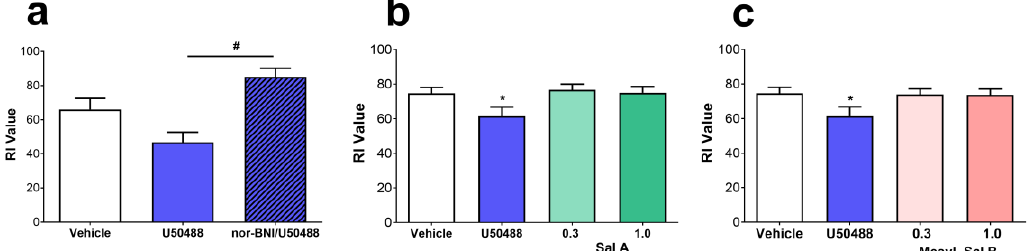
Figure 6. The effects of KOPr agonists on the novel object recognition task. ( a ) Rats treated with U50488 (10 mg/kg) decreased the recognition index (RI) value in the novel object recognition task which was prevented by the prior administration of nor-BNI (10 mg/kg, s.c.; n = 6). No change in the RI value was seen with either ( b ) Sal A or ( c ) Mesyl Sal B at either 0.3 or 1 mg/kg. One-way repeated measures ANOVA with Dunnett’s post hoc tests. Data presented as mean ± SEM; n = 22 for each KOPr treatment groups (* p < 0.05 compared to vehicle; # p < 0.05 compared to U50488).